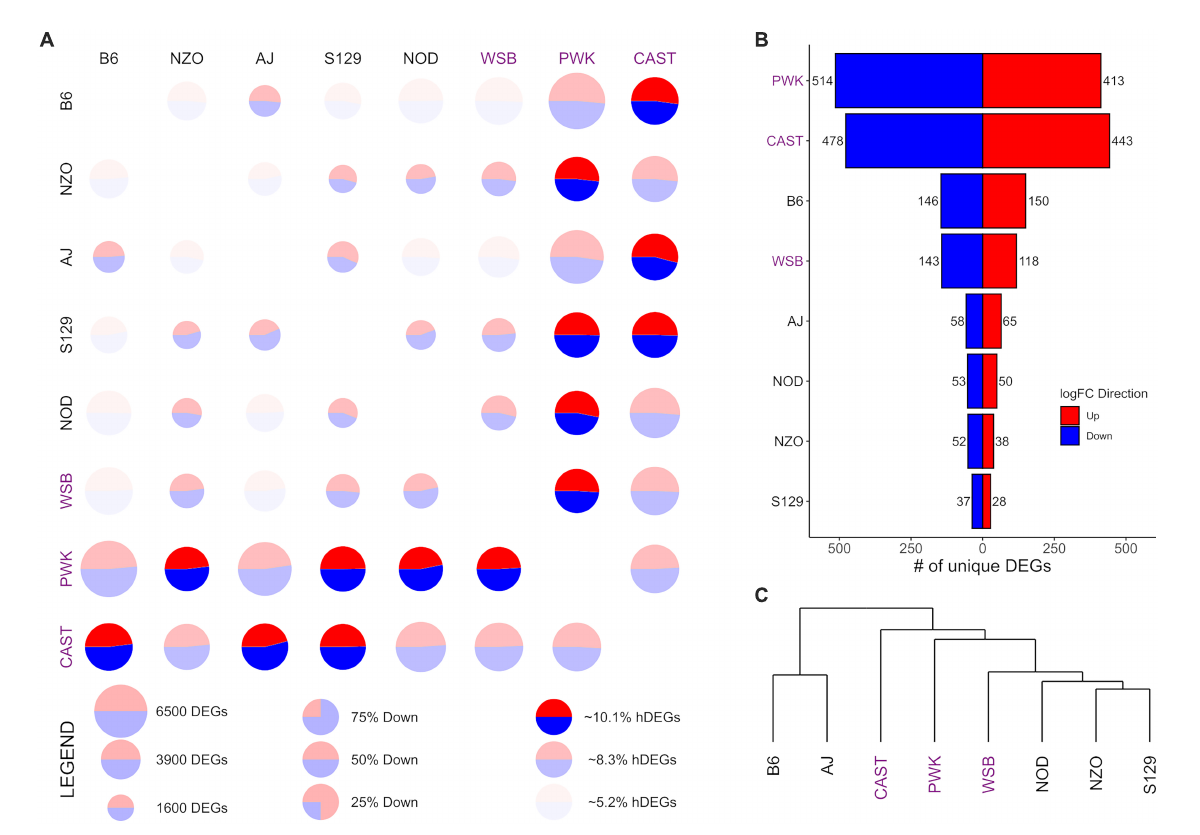
FIGURE3 Differential expression (DE) for nucleus accumbens core (NAcc) samples from the Collaborative Cross founder strains. Wild-derived strains PWK, CAST and WSB, denoted by purple text, have the highest number of DEGs, hDEGs (A) , and unique DEGs (B) . B6 demonstrates the highest differentials for total, hDEGs and unique DEGs among the classical inbred laboratory strains. B6 and AJ cluster separately from all other strains in hierarchical clustering (C)